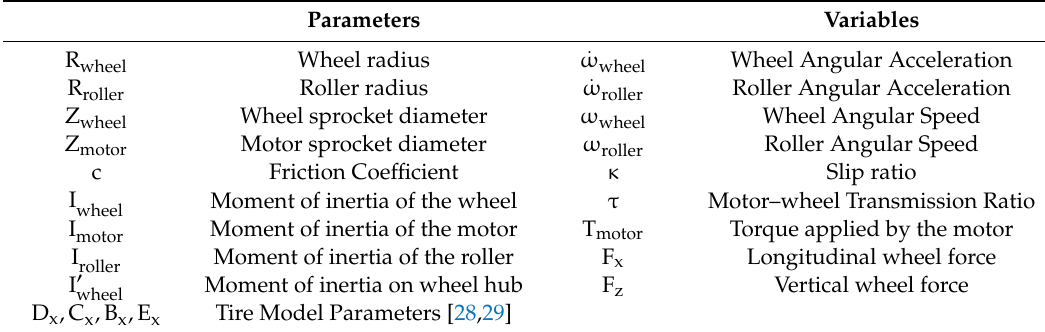
Table 1. Test bench model parameters and variables.